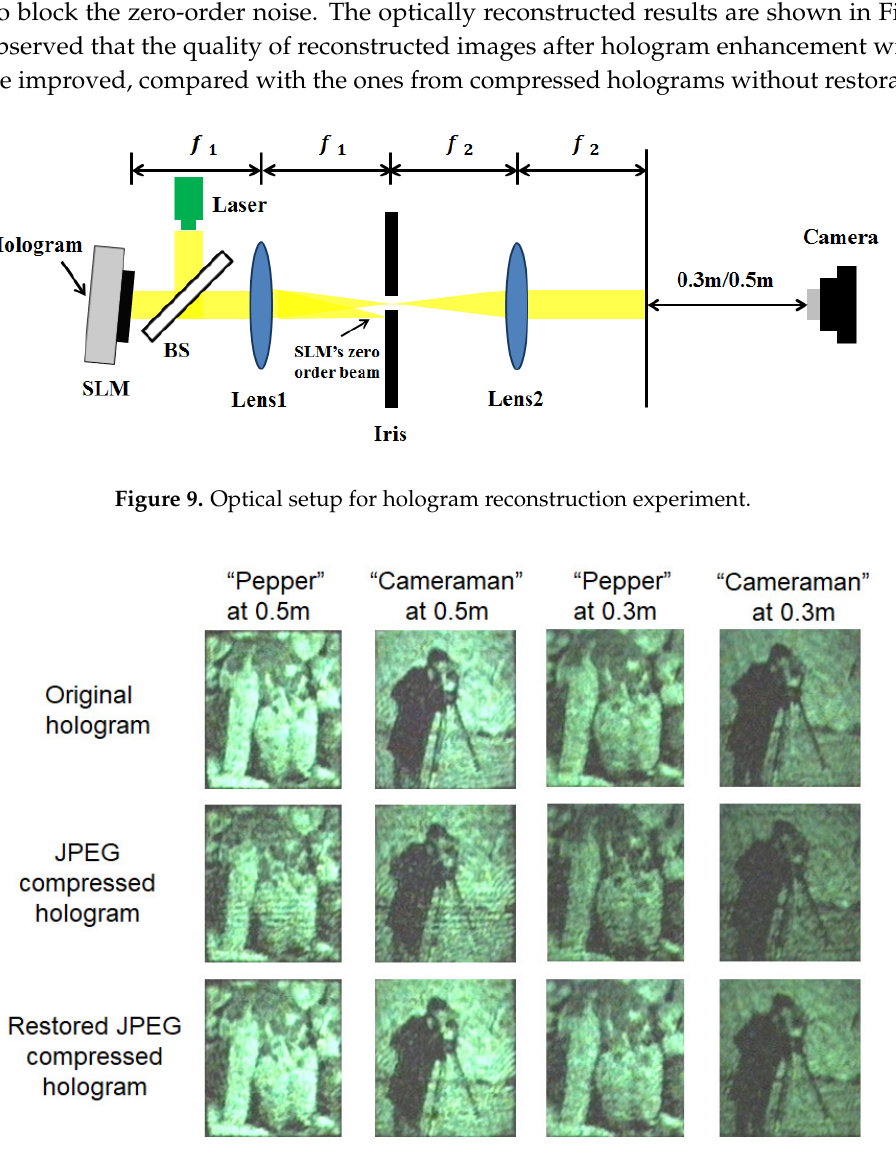
Figure 10. Reconstructed images from original holograms, JPEG compressed holograms and restored holograms in optical